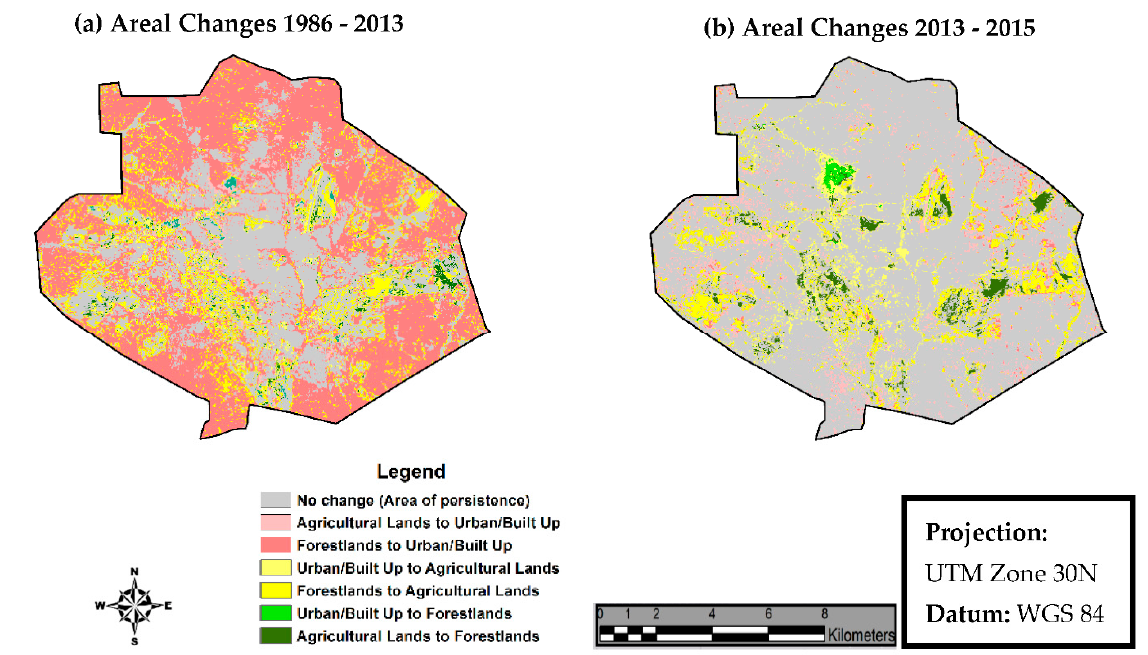
Figure 4. Change Map showing transition of LULC.